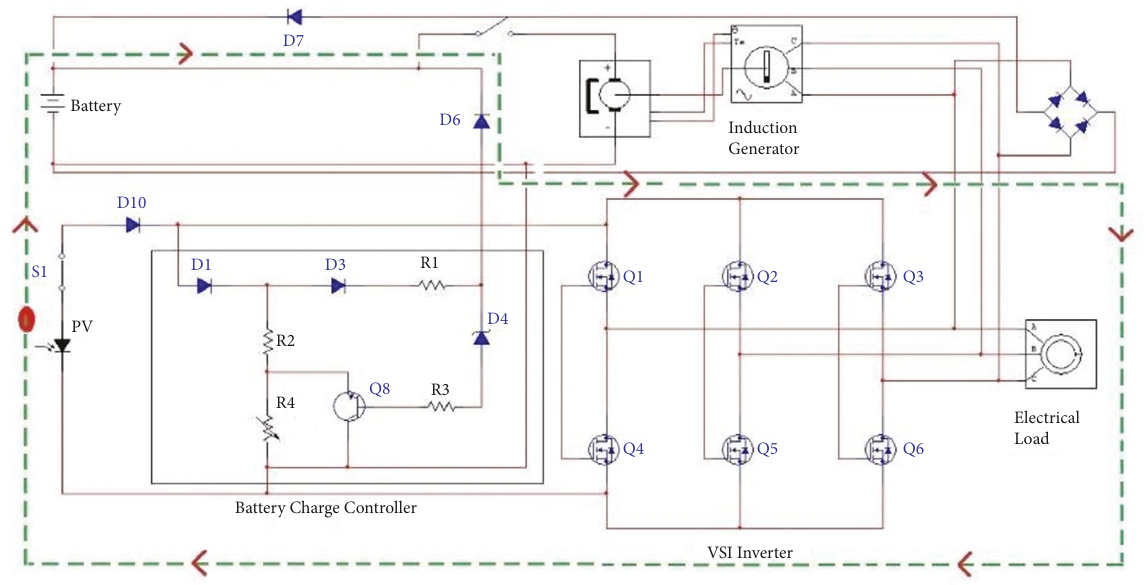
Figure 6: Solar to electrical load.